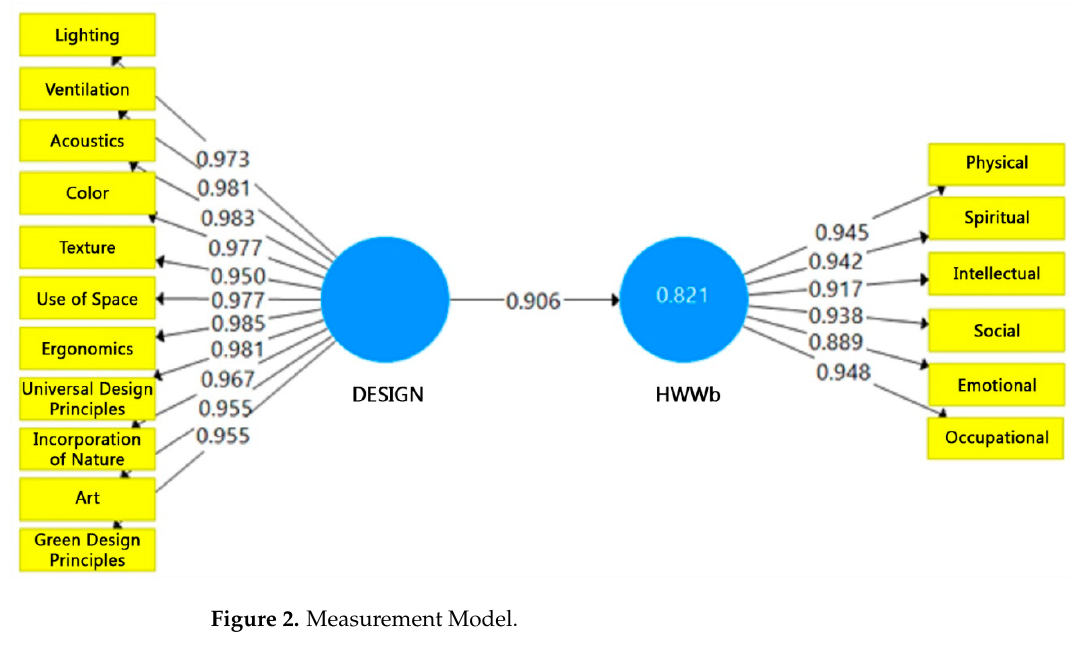
Table 9. Heterotrait-Monotrait Ratio.